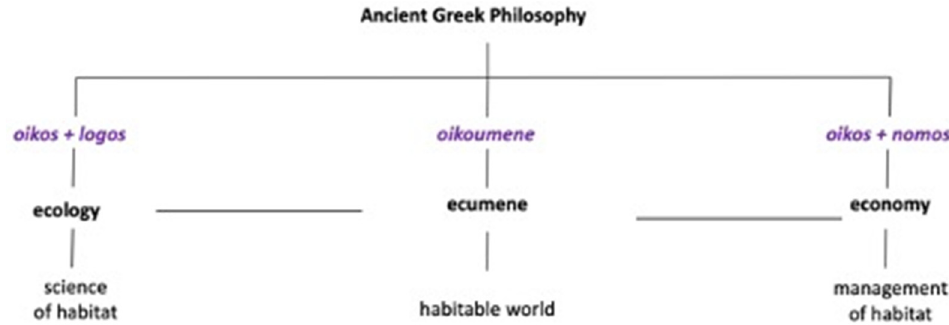
Figure 1. The common linguistic roots of ecumene, ecology, and economy are found in ancient Greek philosophy, but this shared meaning has been forgotten in many contemporary societies. (Source: Author).